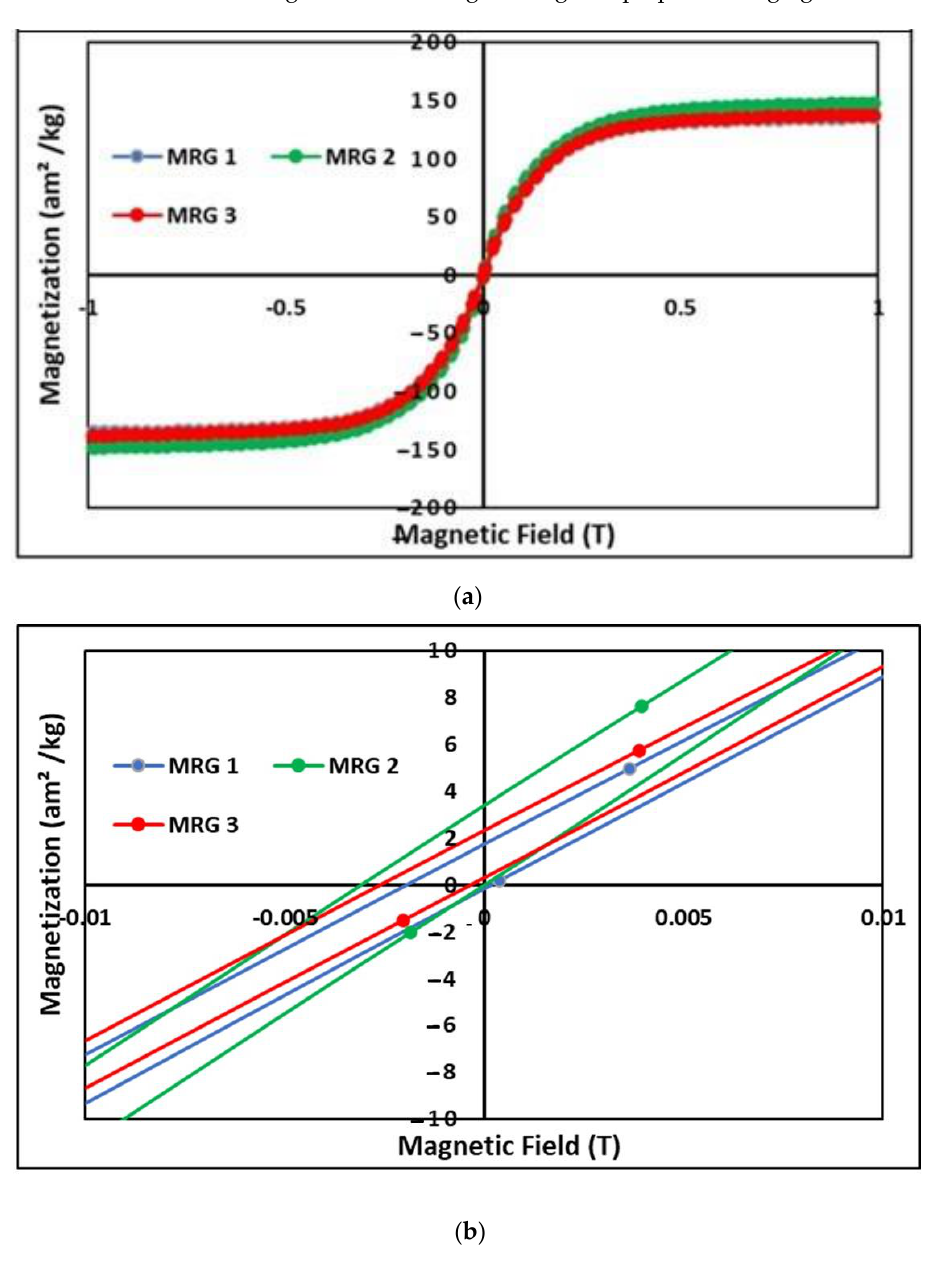
Figure 3. ( a ) The magnetization curve of MRG with different type of oil dilution, ( b ) enlargement of the hysteresis region at various magnetic fields. the hysteresis region at various magnetic